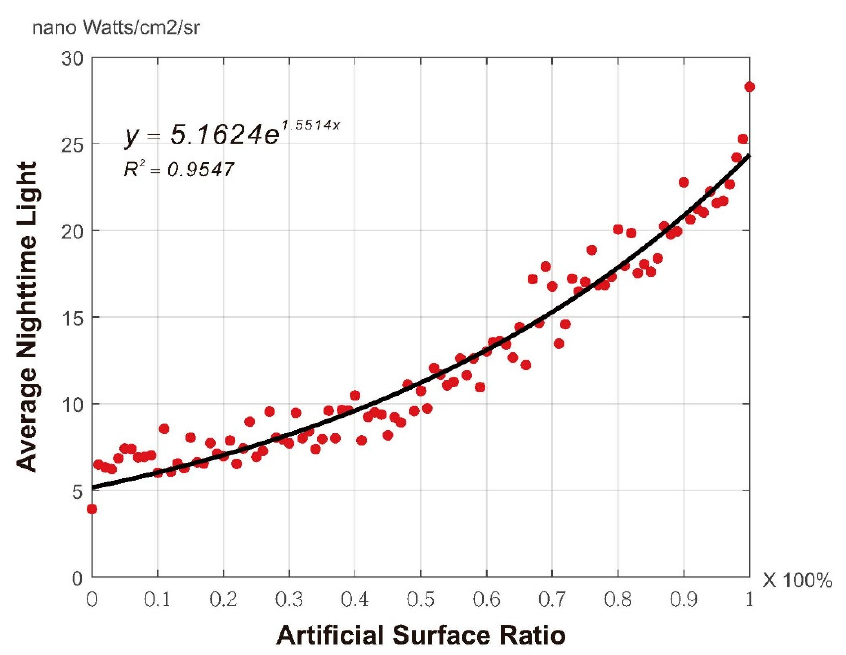
Figure 2. An example of the Spatial–Socioeconomic Urban Development Curve (SSUDC) for Shanghai.